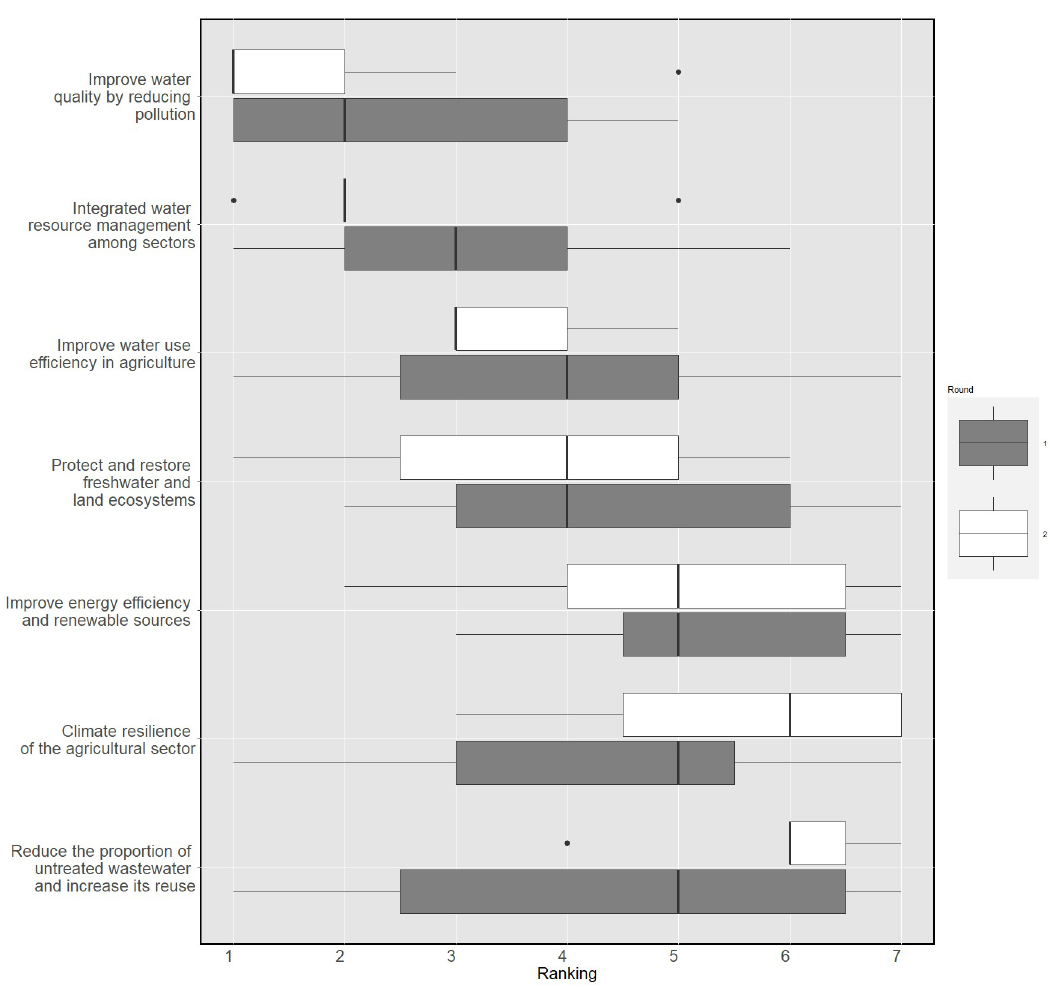
Fig 4. Prioritisation of environmental SDG targets for Apokoronas. KW after the second round was 0.54 (p < 0.001).